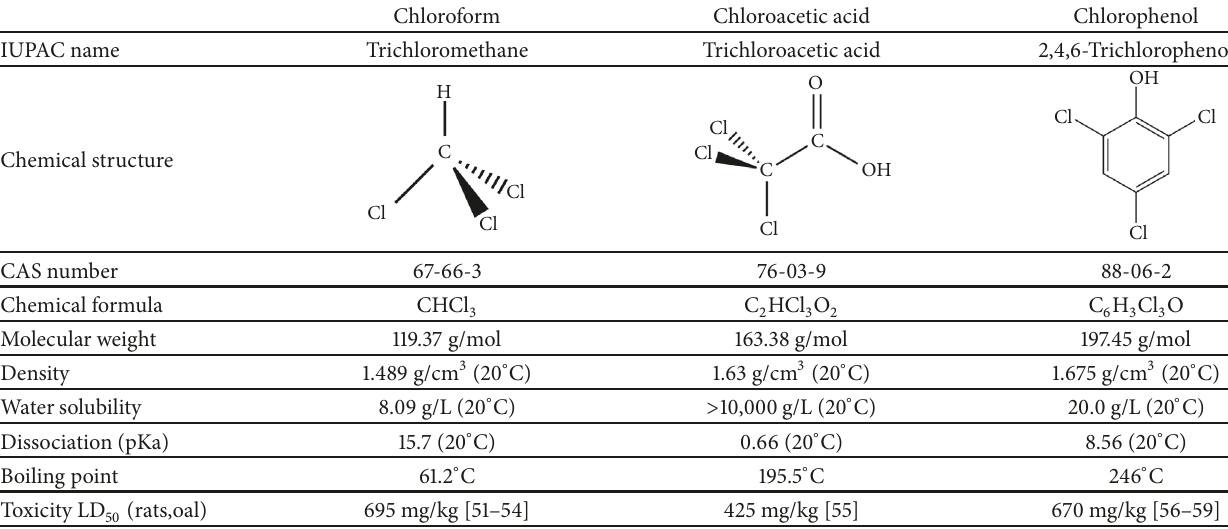
Table 1: Organohalogen characterization table. The table includes physicochemical properties of three primary disinfectant by-products: chloroform, chloroacetic acid, and chlorophenol. The LD 50 values of the materials after oral exposure to rats are also included. These organohalogens are known as mitochondrial toxins and potent disruptors of mitochondrial respiratory